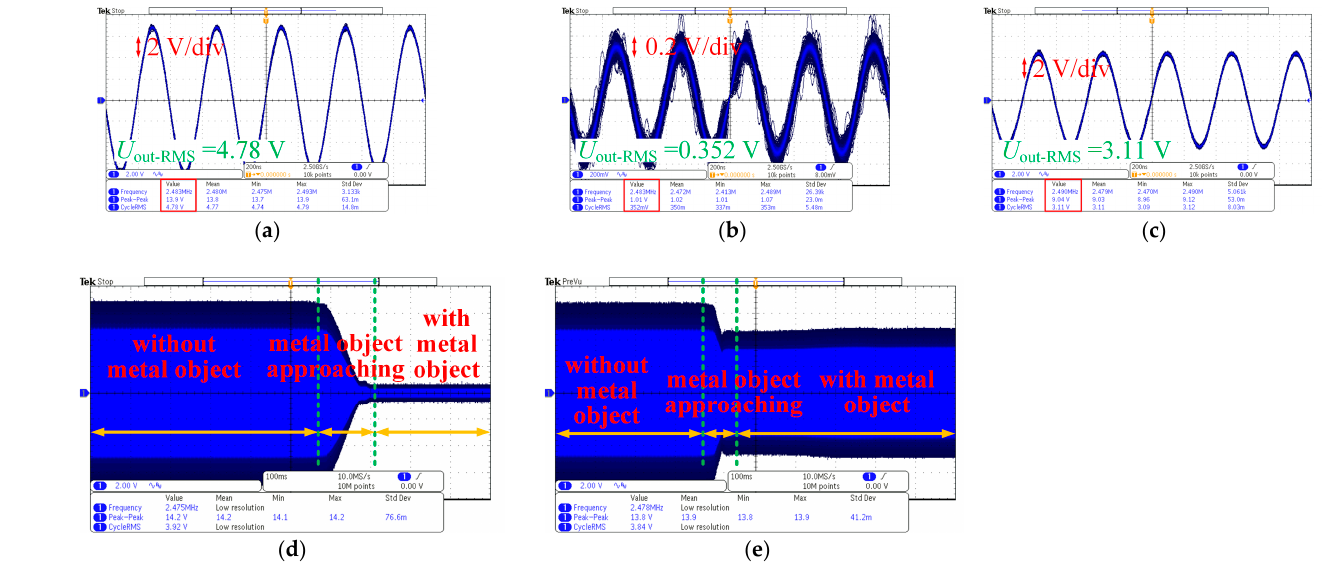
Figure 17. Output waveform of detection circuit U out with excitation frequency f = 2.48 MHz when foreign object was 1 RMB yuan coin. ( a ) Normal condition without foreign metal object. ( b ) Coin in the center position of the detection coil. ( c ) Coin in the corner position of the detection coil. ( d ) The moment of the U out amplitude variation caused by 1 RMB yuan coin entering the center position of the detection coil. ( e ) The moment of the U out amplitude variation caused by 1 RMB yuan coin entering the corner position of the detection coil.